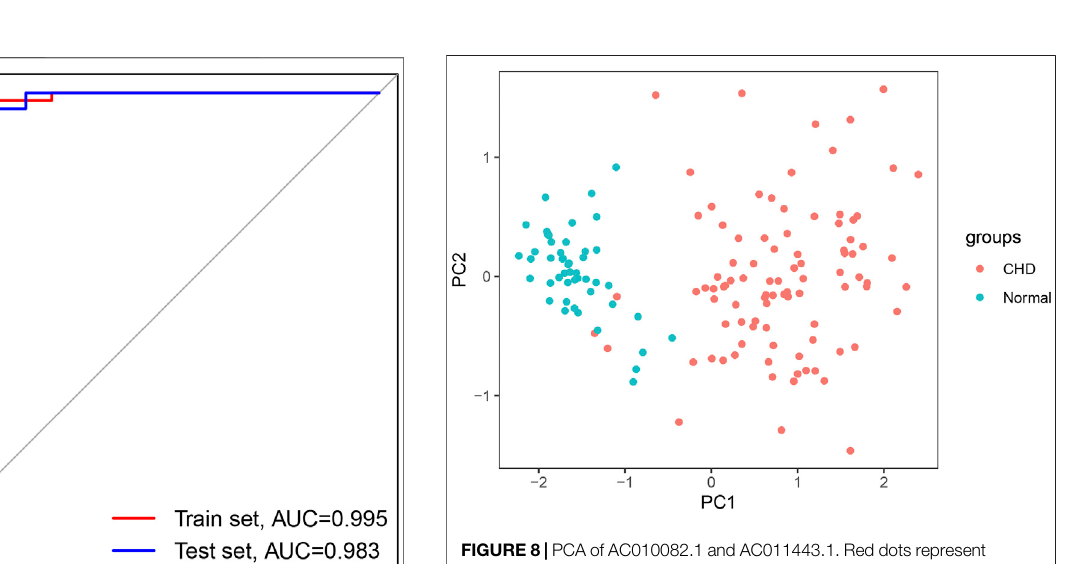
FIGURE 6 | Top 10 terms obtained using GO functional and KEGG pathway enrichment analyses.